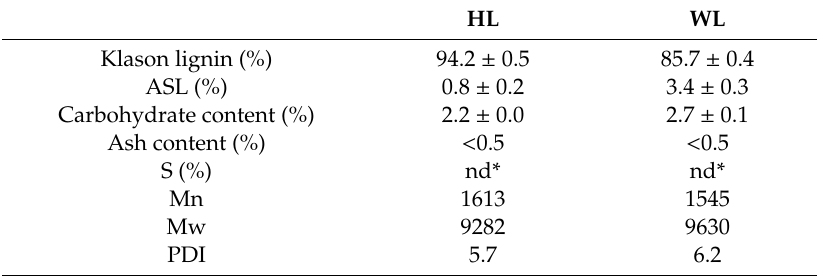
Table 1. Chemical composition (dry basis %) and molecular weight distribution of